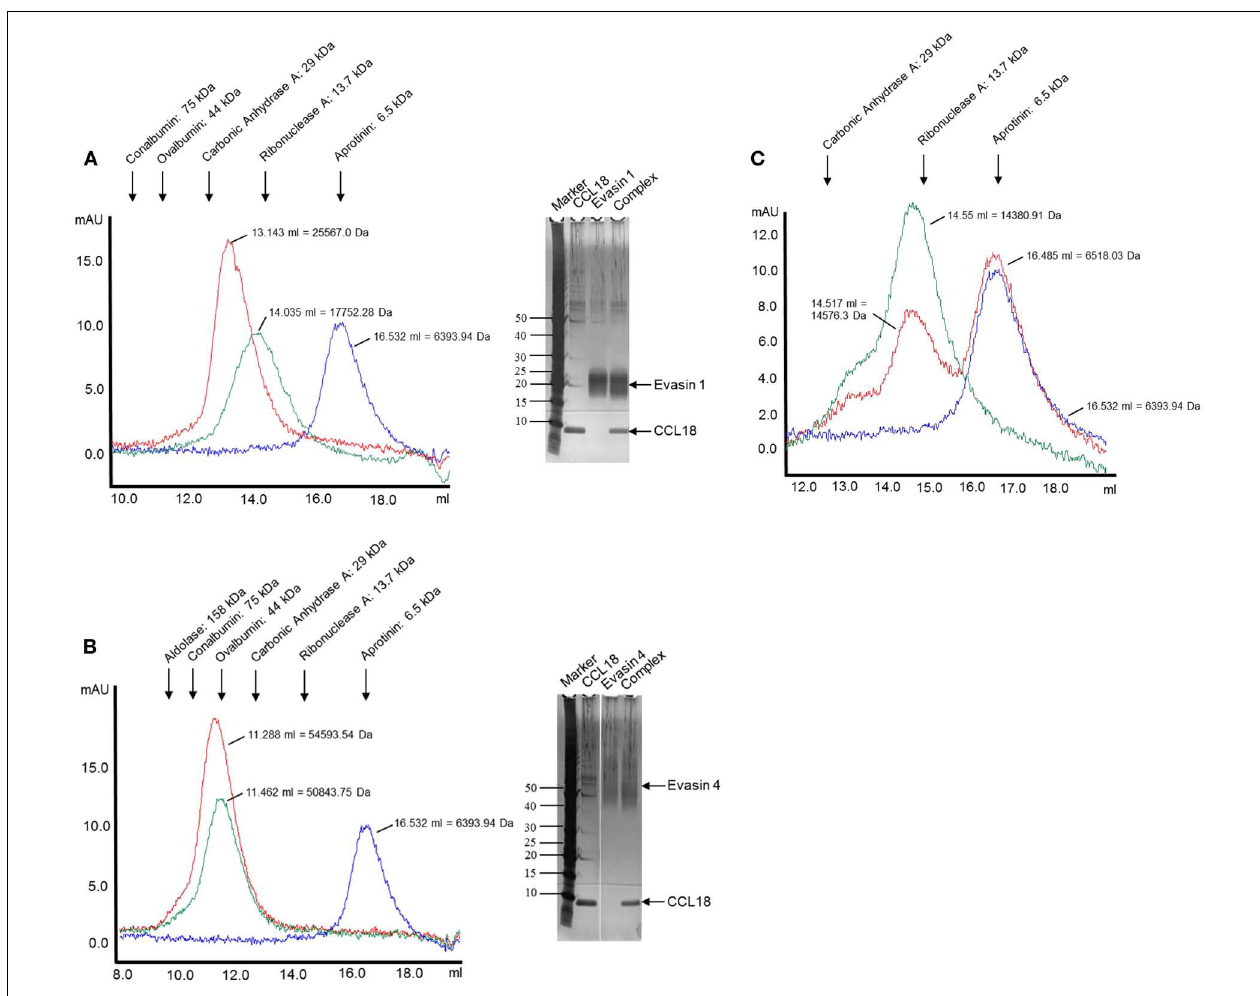
corresponding molecular weight are indicated for each peak.The elution volume of each protein used for calibration is indicated on the top according to their molecular weights. (A,B) SDS-PAGE analyses were performed with the fractions corresponding to the peak elution fractions. SDS-PAGE stained with silver. One representative experiment out of two is